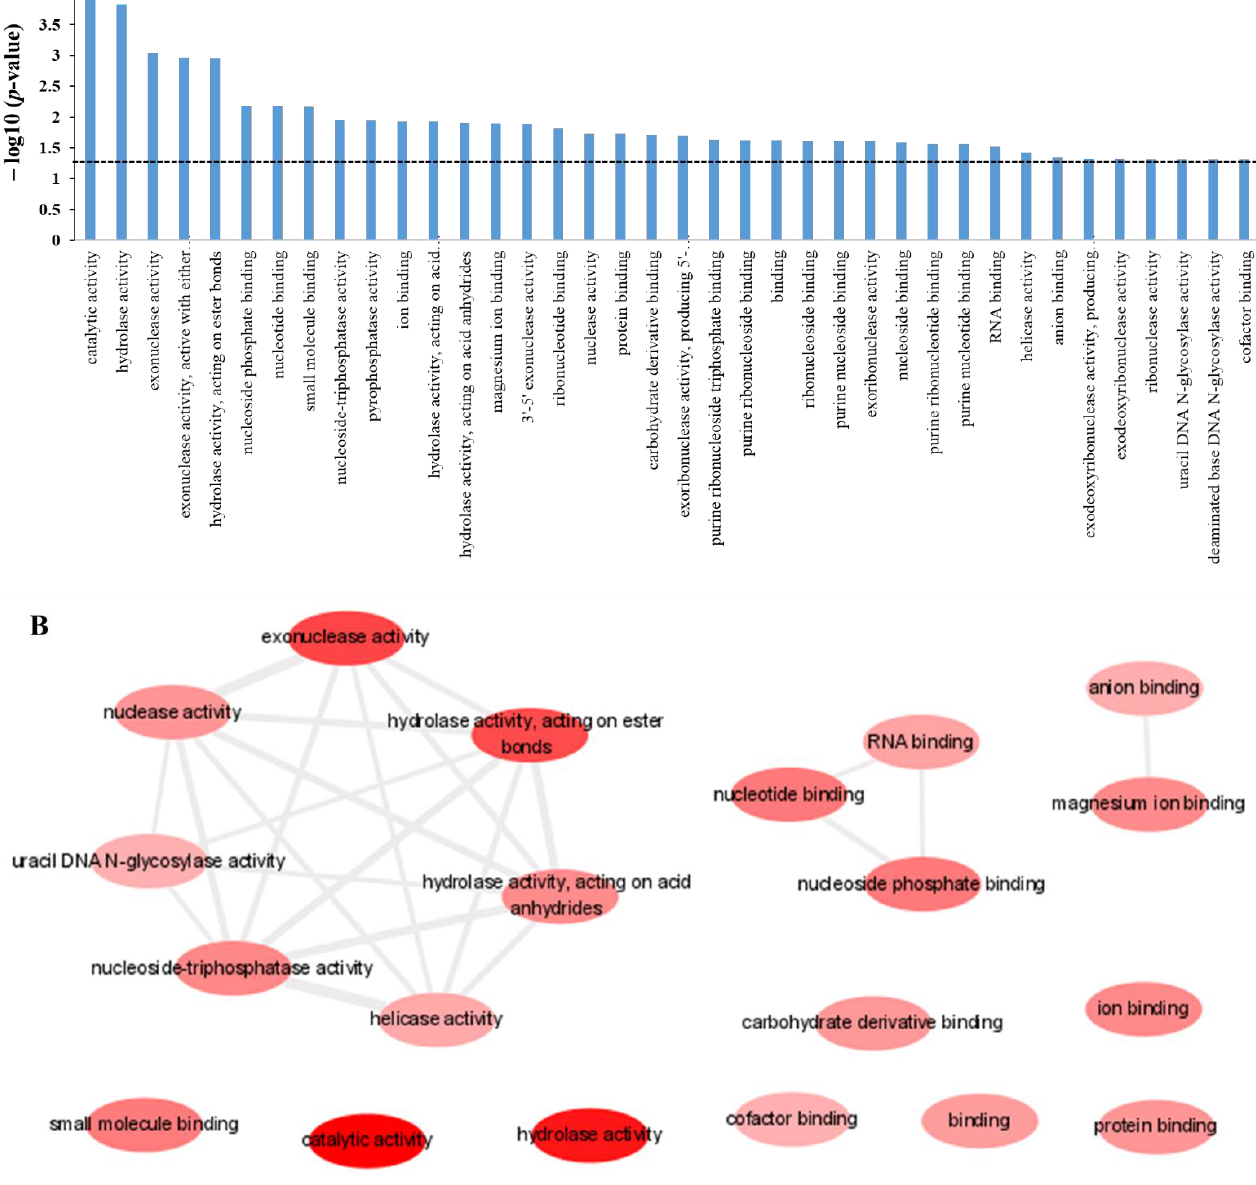
Figure 3. Enrichment in molecular function category of gene ontology (GO) for the protein targets of polyphemusin-I. ( A ) GO molecular function enriched terms analyzed by DAVID database using a p -value cutoff of ≤ 0.05 (dotted line represent p -value = 0.05). ( B ) REVIGO analysis for the selection of non-redundant GO term from the list of DAVID generated GO enrichment results in molecular function. Bubble indicated enriched non-redundant GO term and the color (red to pink) represent significant enrichment based on the p -value. The highly similar non-redundant GO terms are connected with the line where the width of the line represented the degrees of similarity. Table 1. Enrichment analysis of protein targets of polyphemusin-I in molecular function category of Gene Ontology (GO). Term_ID